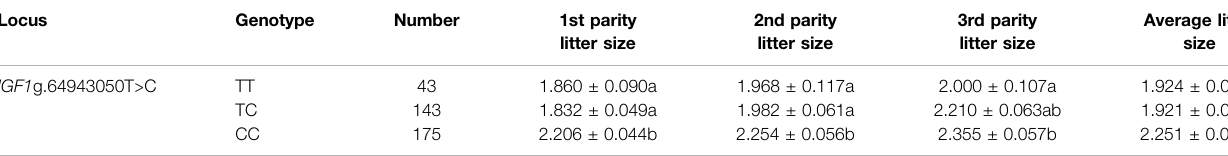
TABLE 3 | Least squares means and standard errors of litter size in black goats with different genotypes. Locus